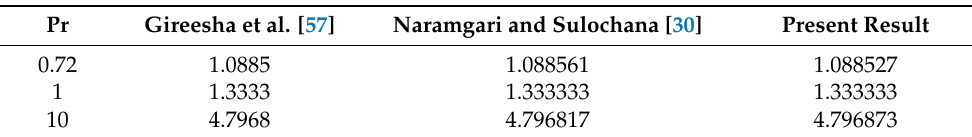
Table 4. Comparative values of − θ (cid:48) ( 0 ) for stretching sheet ( λ = 1 ) when ϕ 1 = ϕ 2 = L = B T = B v = Ec = 0 and σ 2 = 0.